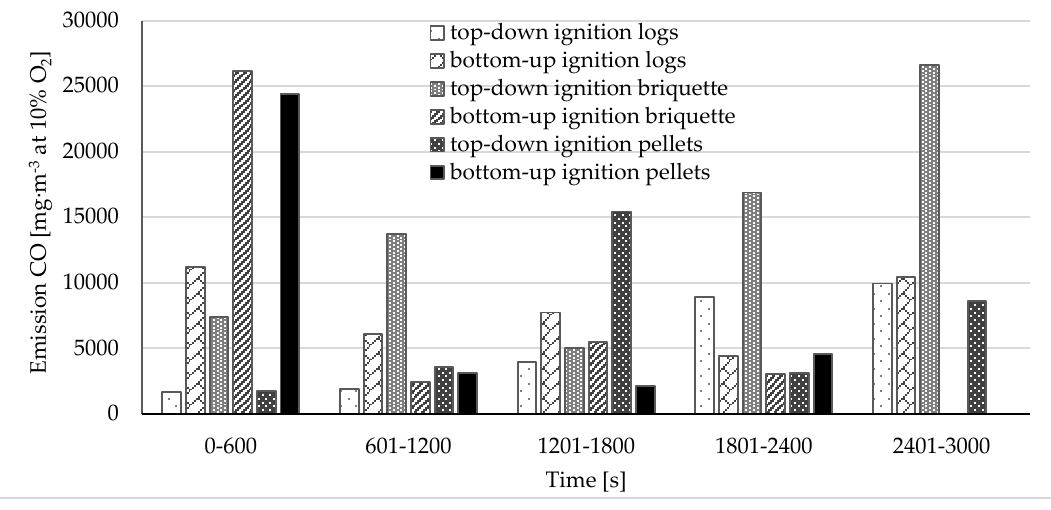
Figure 3. Changes in carbon monoxide emission during the combustion of the selected biomass forms (average values for separate combustion phases and ignition techniques).